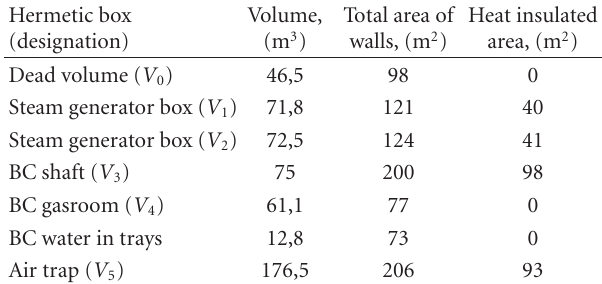
Table 1: Geometrical parameters of the hermetic compartments of the test